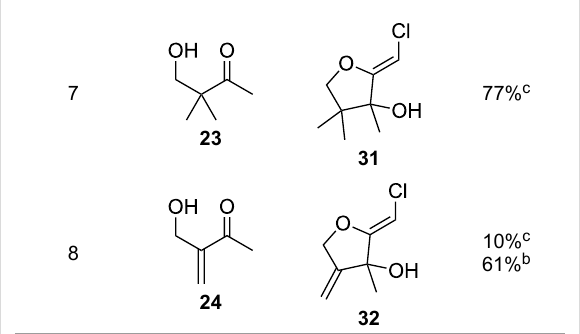
Table 1: Preparation of (Z)-chloro- exo -methylenetetrahydrofurans.